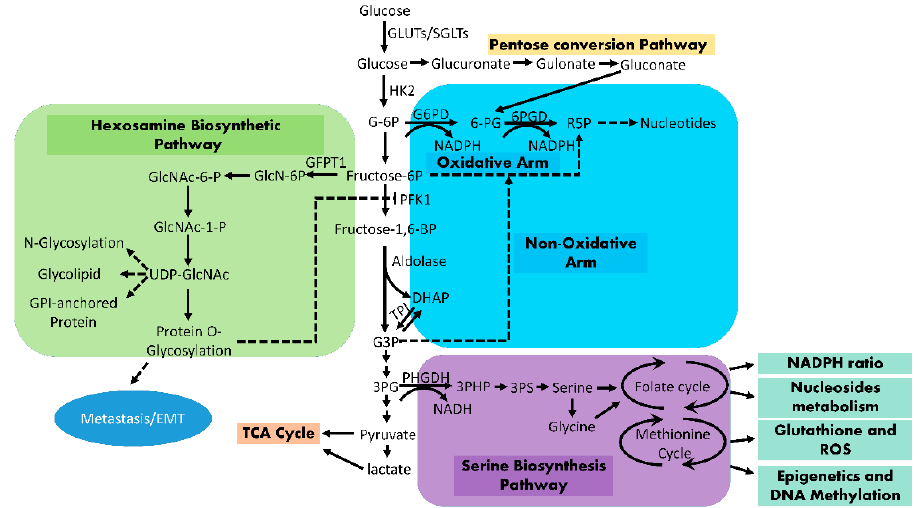
Figure 2. Enhanced glucose flux into anabolic pathways in PDAC.